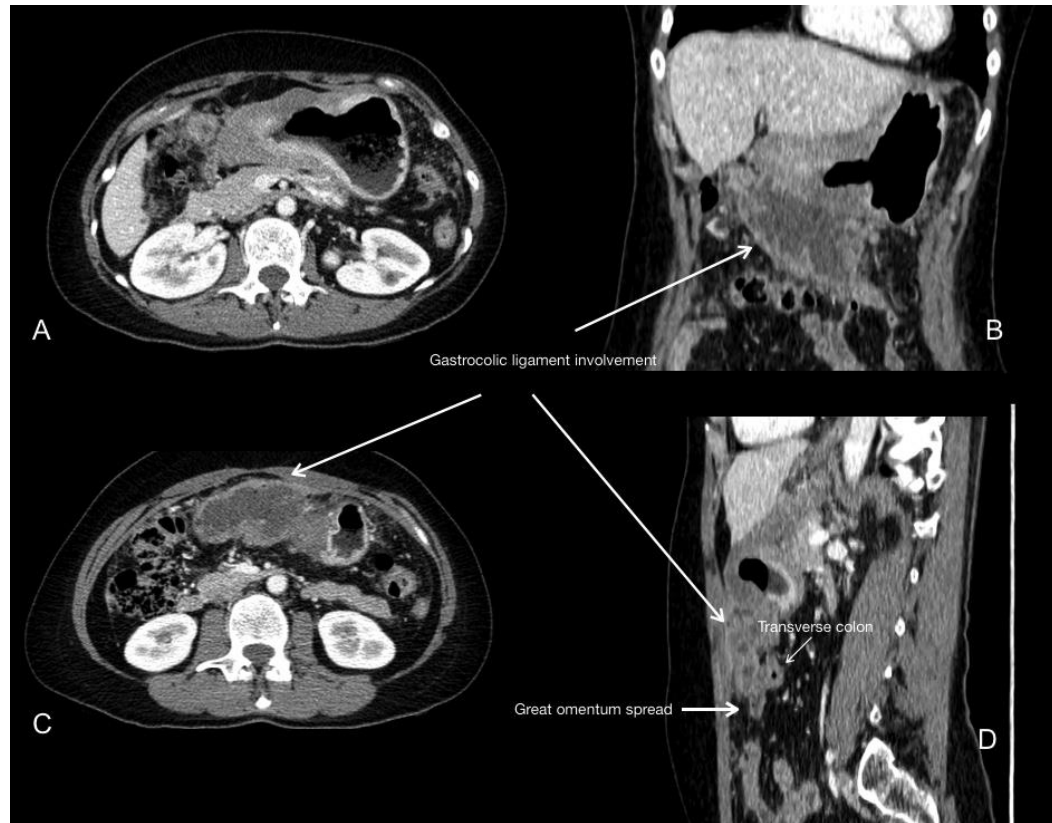
Figure 2. Primary gastric cancer involving distal body and antrum. Portal phase contrast-enhanced CT axial ( A , C ), coronal ( B ) and sagittal ( D ) images show the tumour spreading inferiorly along the gastrocolic ligament, reaching the transverse colon and involving the greater omentum.